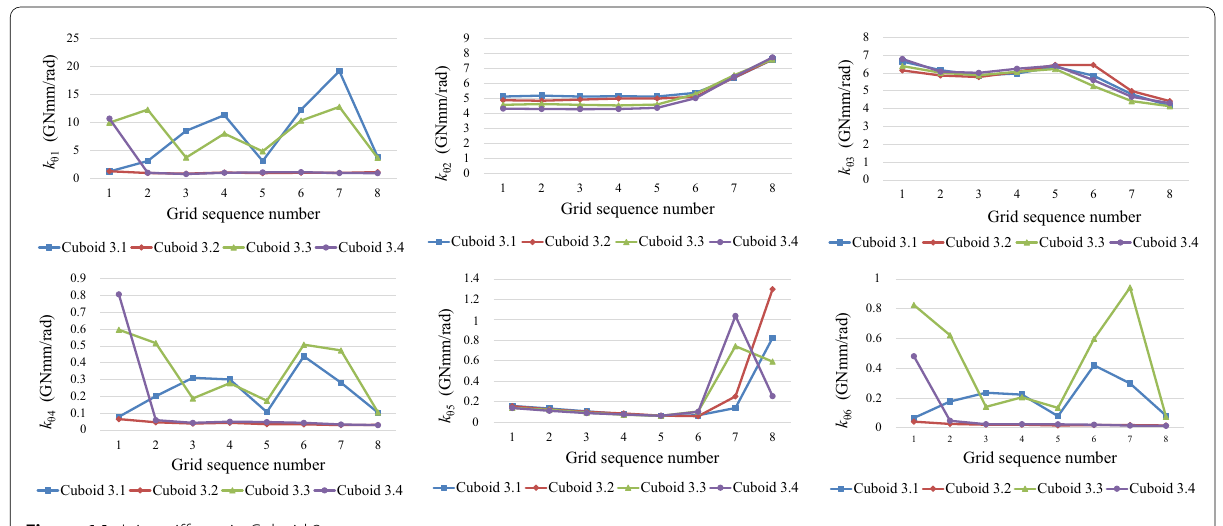
Figure 14 Joint stiffness in Cuboid 3